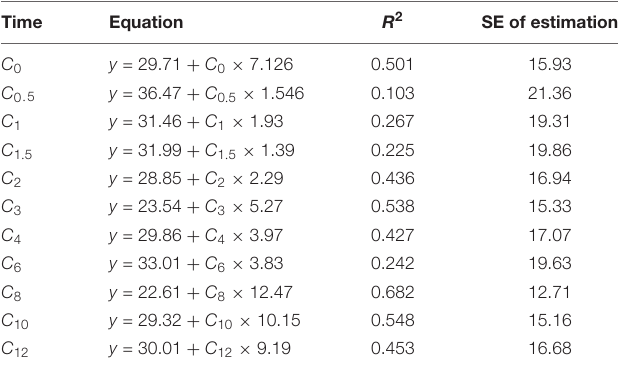
TABLE 3 | Univariate correlation between the MPA plasma concentration at each time point and the AUC 0 − 12 h .